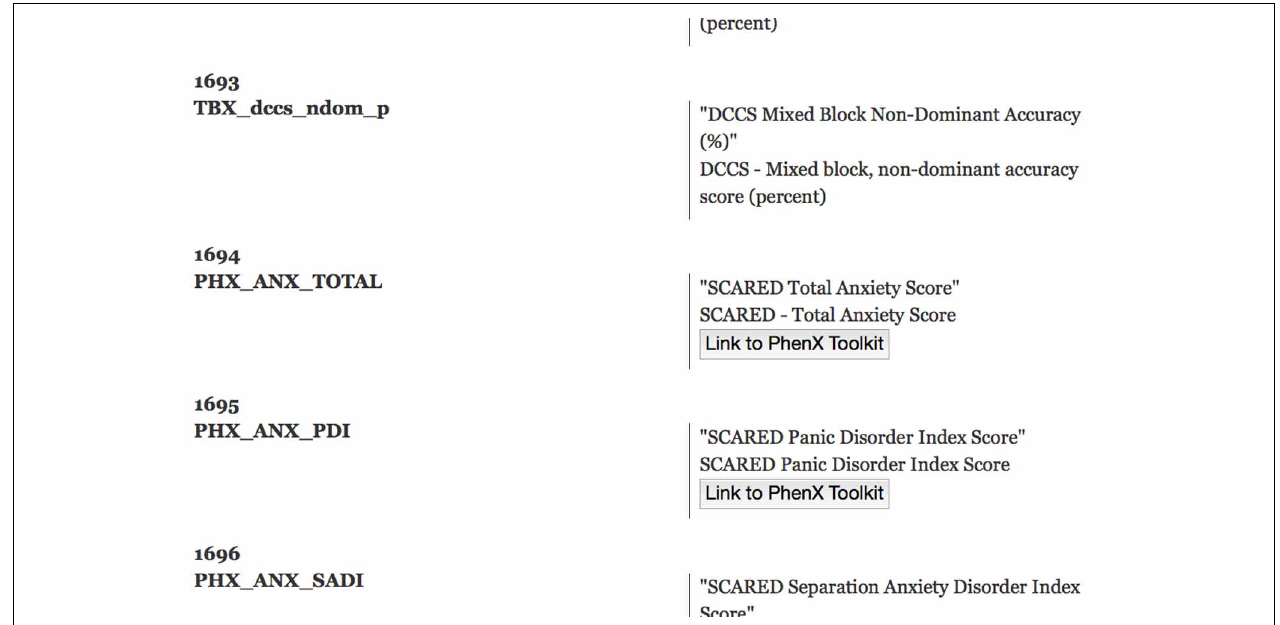
FIGURE 5 | Screen capture of a section of the data dictionary displaying NIH toolbox measures. A sequential number is displayed together with the dictionary term on the left side of the page. On the right side, the corresponding axis label (top) and the available long